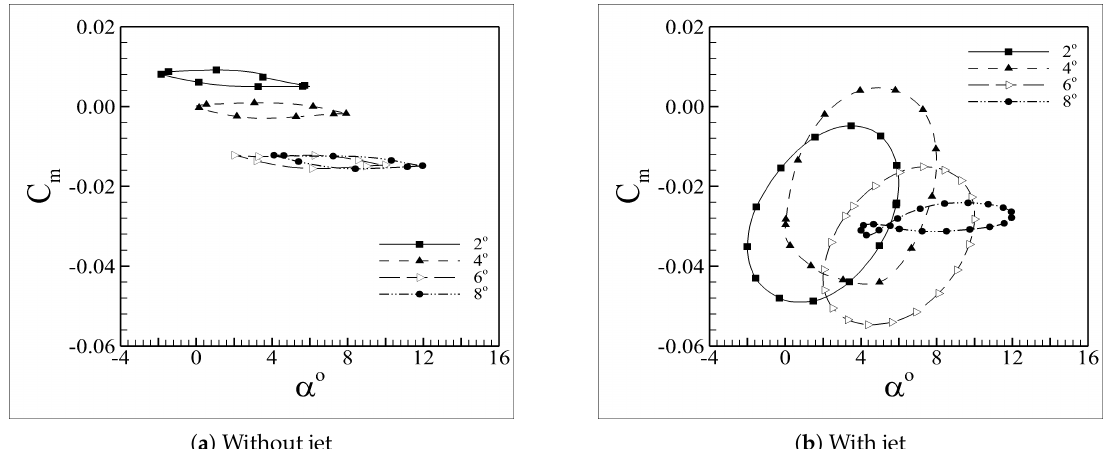
Figure 16. Comparison of pitch moment coefficient C m for α o = 2 ◦ to 8 ◦ with constant amplitude ( α A = 4 ◦ ).